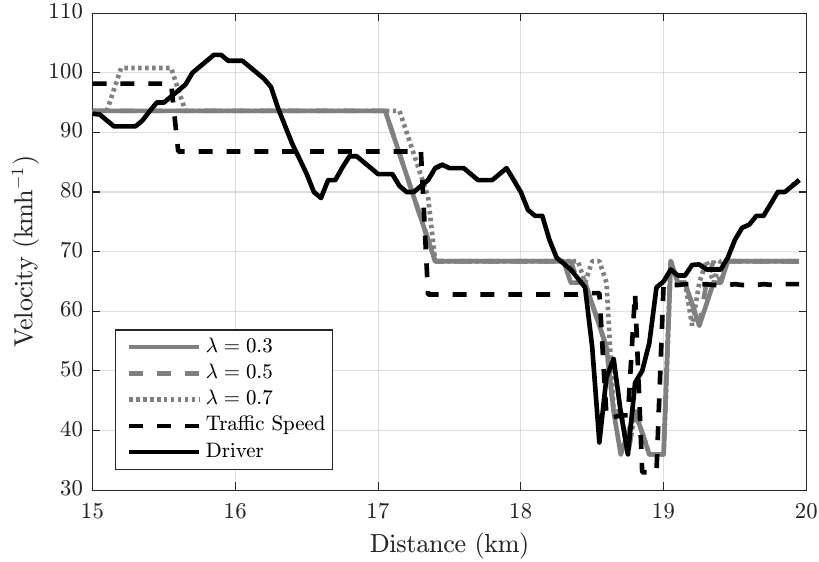
Figure 8. Traffic speed-constrained velocity profiles from DP and driver data with a 10% limit above the traffic speed-constraining DP algorithm. Driver velocity (solid black), traffic speed (dashed black), algorithm profiles with λ = 0.7 (dotted), λ = 0.5 (dashed) and λ = 0.3 (solid